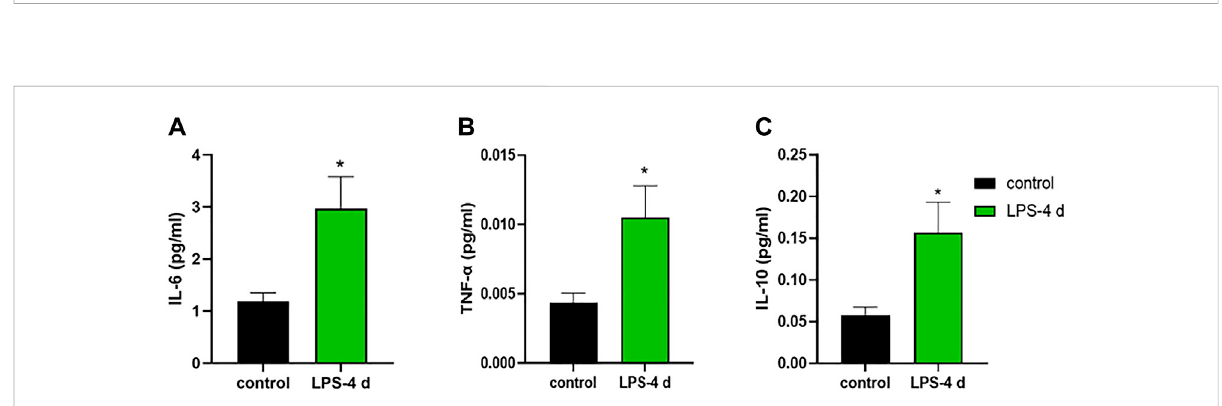
FIGURE 11 Levels of interleukin (IL)-6, tumor necrosis factor (TNF)- α , and interleukin (IL)-10. (A) IL-6 level in the control group and the LPS-4 d group. (B) TNF- α levelinthecontrolgroupandtheLPS-4dgroup. (C) IL-10levelinthecontrolgroupandtheLPS-4dgroup.Dataareexpressedasthemean± SEM ( n = 6). * p < 0.05, compared to the control